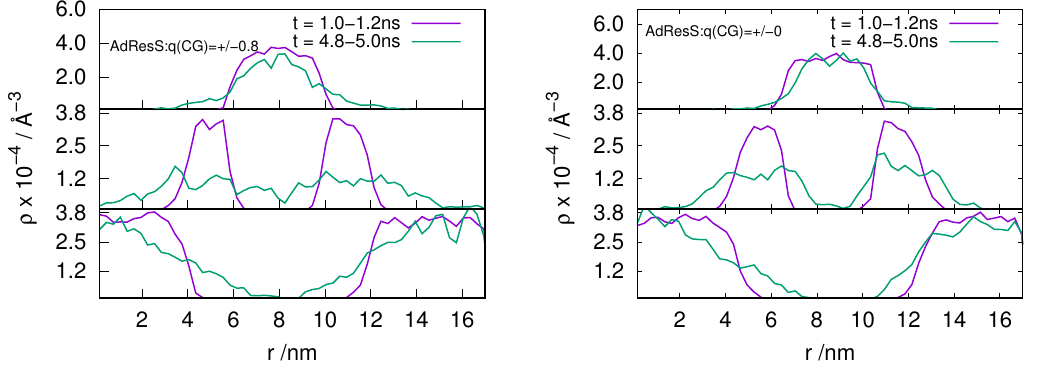
Figure 2. Evolution in time of an instantaneous diffusive number density profile along the trajectory for the ion pairs that are at time, t = 0, located in the atomistic region (top panel), hybrid region (middle panel) and in the coarse-grained region (bottom panel). GC-AdResS simulation with the charged and uncharged coarse-grained model of the [BMIM][Cl] system is shown in left and right respectively. Exchange of ion pairs among different regions are shown.